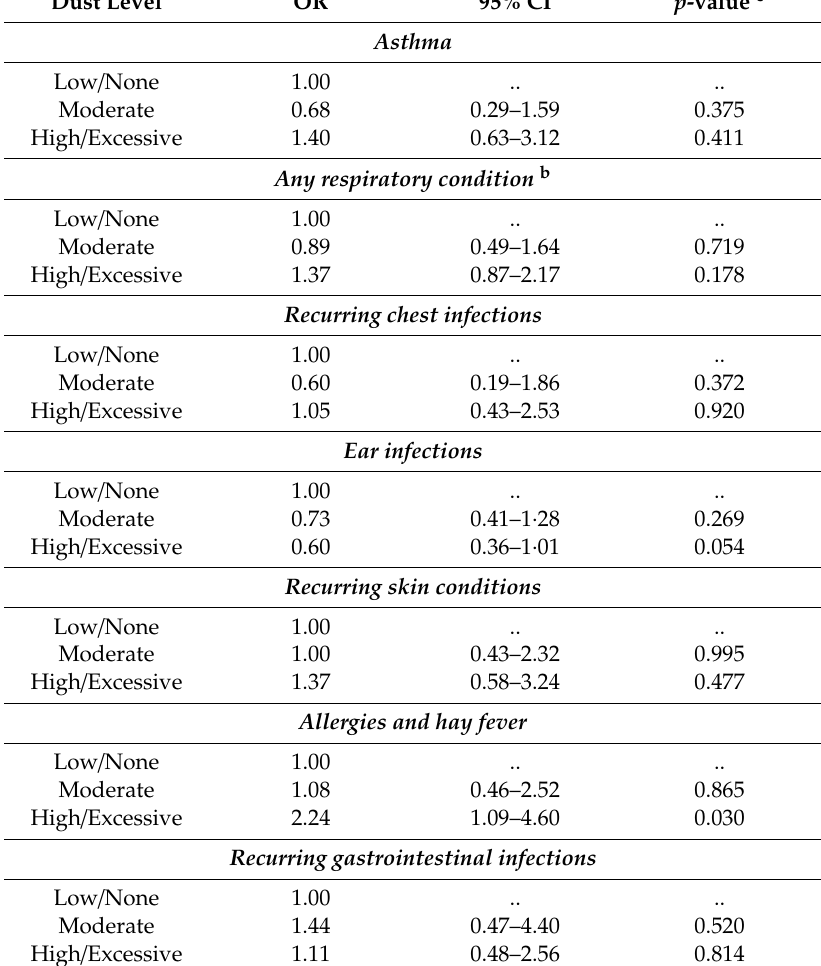
Table 1. Relationships between perceived level of dust in the community (Environmental Health Needs Survey (EHNS)) and parent-reported (Western Australian Aboriginal Child Health Survey (WAACHS)) health outcomes among Indigenous children aged 0–17 years in discrete communities of Western Australia, 2000–2002 a